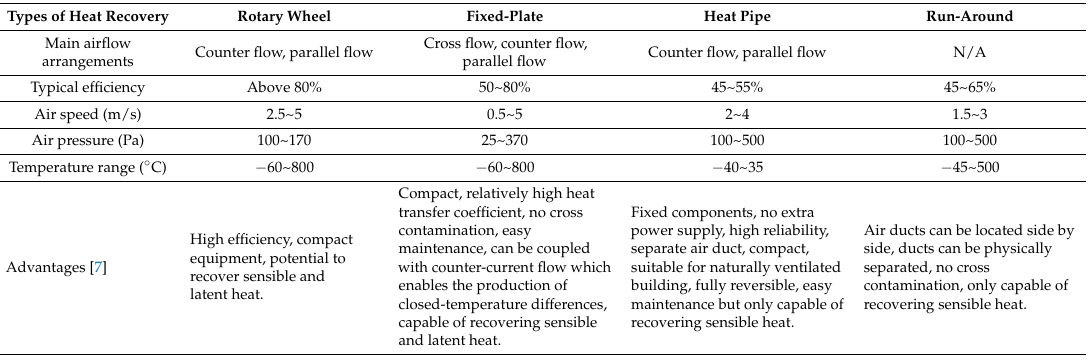
Table 1. A comparison of the four types of heat recovery systems based on their thermal performance.